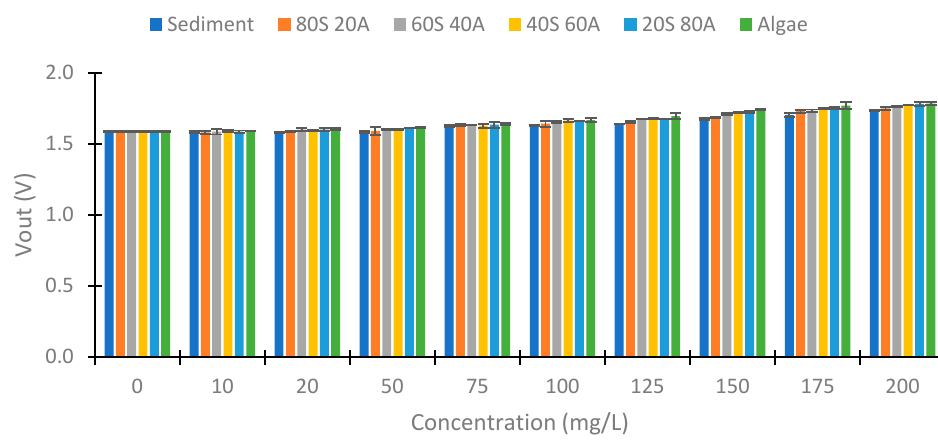
Figure 12. Vout with the use of red light at voltage divider LDR at 180 ◦ .